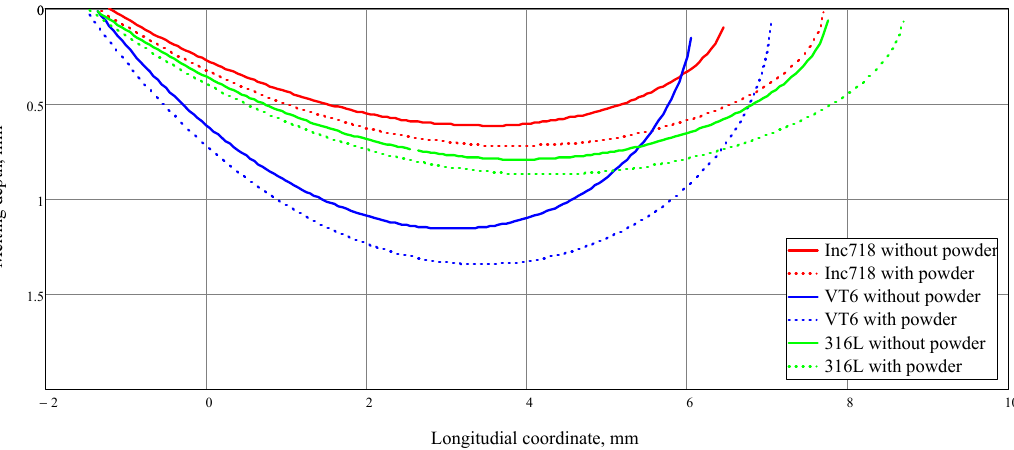
Figure 4. Temperature distribution along the melt pool length. Laser power was 2000 W, motion speed was 20 mm/s, laser beam radius on the surface was 2.5 mm, powder jet diameter was 3 mm, and powder feed rate was 2 kg/h.